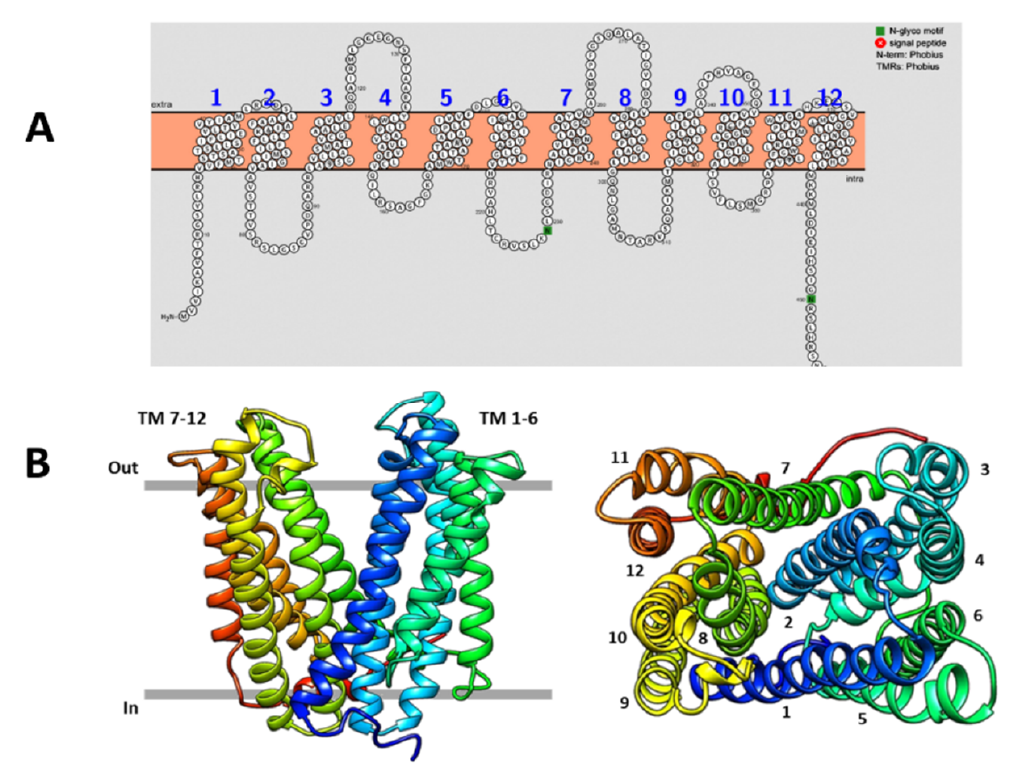
Figure 4. Predicted membrane topology and structure of the Psn23 MatE transporter. ( A ) Twelve putative transmembrane (TM) domains were predicted for Psn23 MatE, on the basis of amino acid hydrophobicity; ( B ) Ribbon three-dimensional (3D) model of Psn23 MatE, viewed parallel to the membrane (left) and along the membrane normal from the periplasmic side (right), with the twelve TM helices numbered starting from the first N amino acid (methionine).